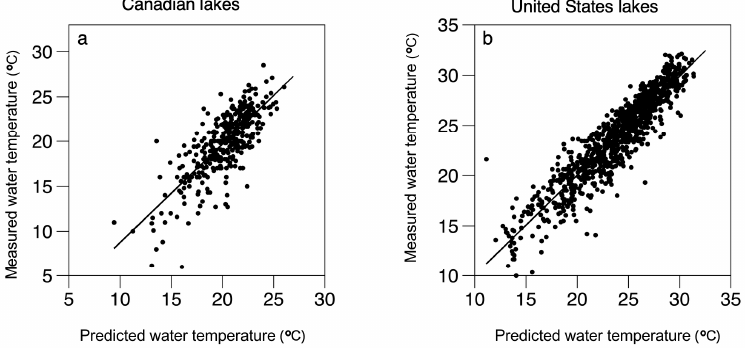
Figure 4. Plots of measured water temperatures at 1 meter in Canadian ( a ) and United States ( b ) lakes versus predicted water temperatures based on equations developed for the lakes in the months of June, July, August and September for each country separately. Lines represent fitted regression lines.